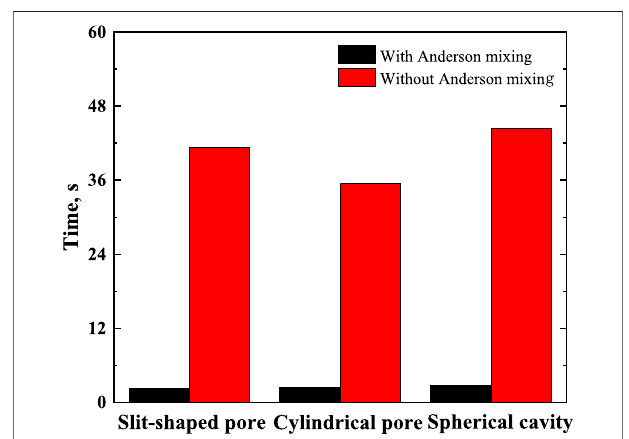
FIGURE 2 | Time required for calculating equilibrium density pro fi le (not including the time for calculating the matrices required in the Chebyshev pseudo-spectral collocation method).